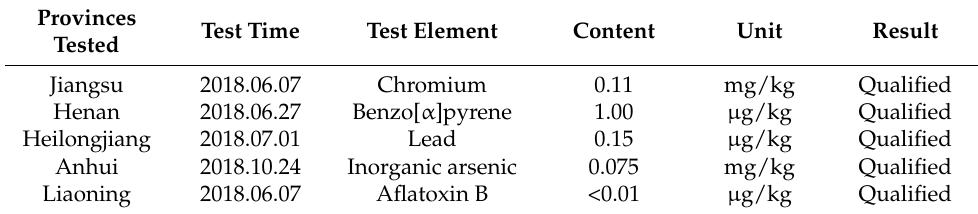
Table 2. Sample of rice hazards testing